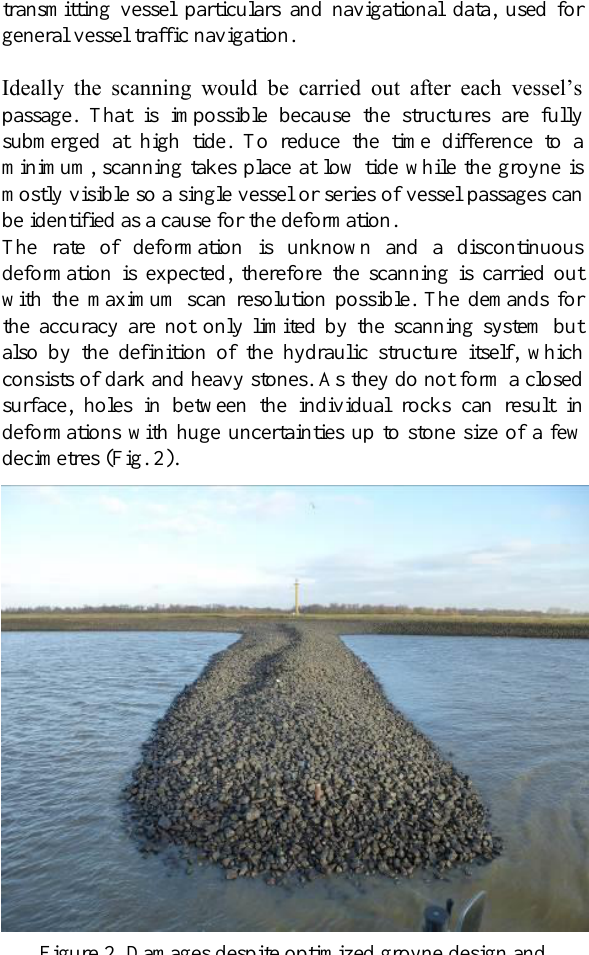
Figure 2. Damages despite optimized groyne design and